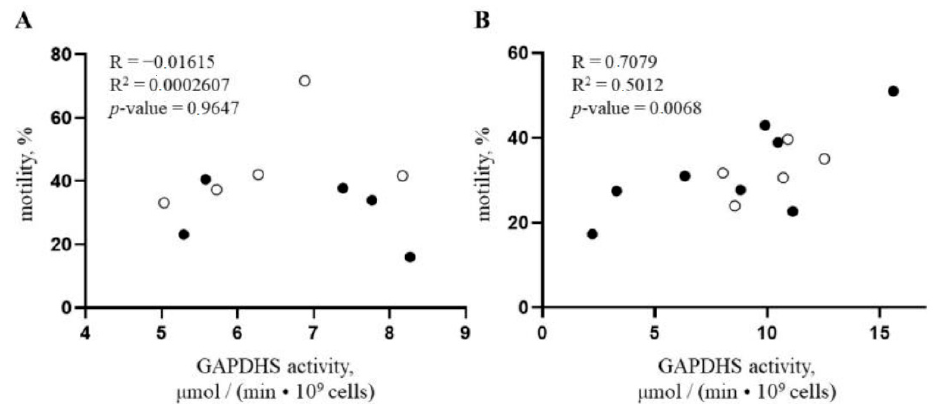
Figure 4. Correlation between GAPDHS activity and the percentage of motile spermatozoa five minutes post-thawing for samples of conventional bovine sperm ( A ) and for samples enriched with X-chromosome-bearing gametes ( B ). Analyzed frozen-thawed samples derived from the same bull are shown with white circles and samples derived from different animals are shown with black dots. Statistics were calculated using the Pearson correlation